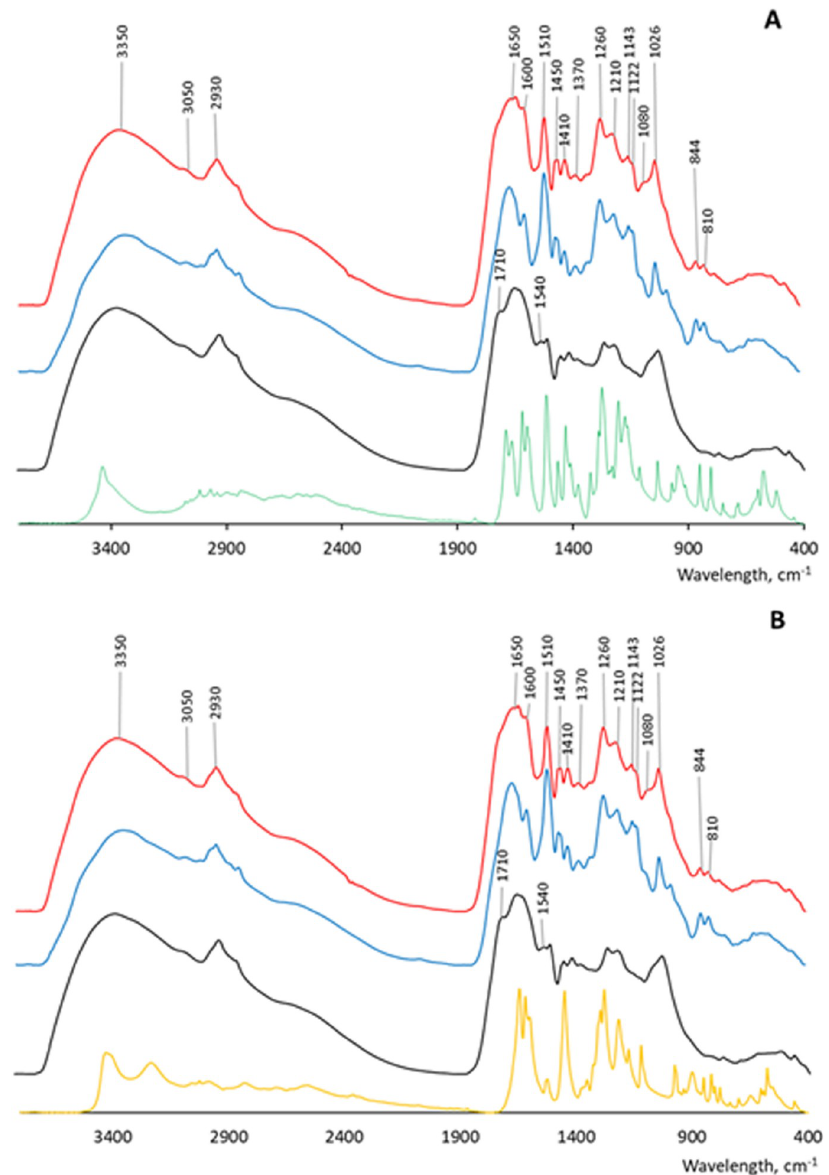
Fig 5. Infrared spectra (KBR-technique) of the products of the interaction of two-domain laccase of S . puniceus (SpSL) with humic acid (HA) in the presence and absence of: (A) ferulic acid; (B) caffeic acid. Black line–initial humic acid; green line–initial FA; yellow line–initial CA; blue line—phenolic acids after interaction with SpSL; red line–HA- phenolic acid mixtures after interaction with SpSL. The spectrum of the HA after interaction with SpSL was identical to the spectrum of initial HA and is given in (S1